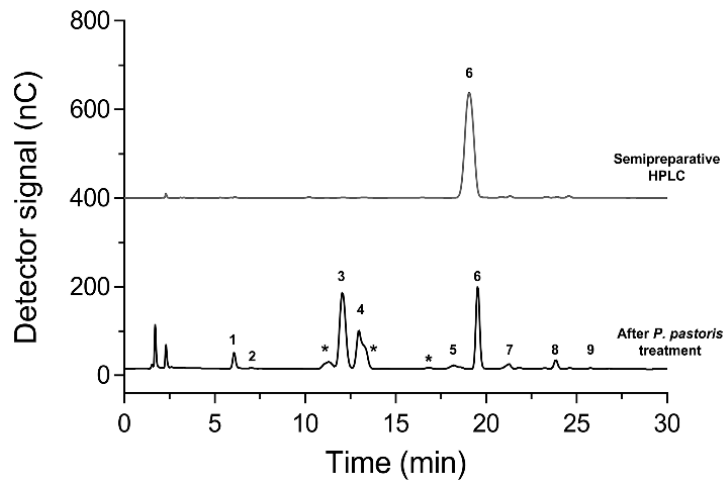
Figure 4. Chromatographic analysis of isomelezitose purification. HPAEC–PAD chromatograms of the hetero-GlcOS mixture treated with immobilised K. phaffii cells (black line) and the purified isomelezitose by semipreparative HPLC (grey line) are shown. Peaks assignation: (1) glucose, (2) fructose, (3) sucrose, (4) trehalulose, (5) melezitose, (6) isomelezitose, (7) theanderose, (8) erlose and (9) esculose. (*) unknown.